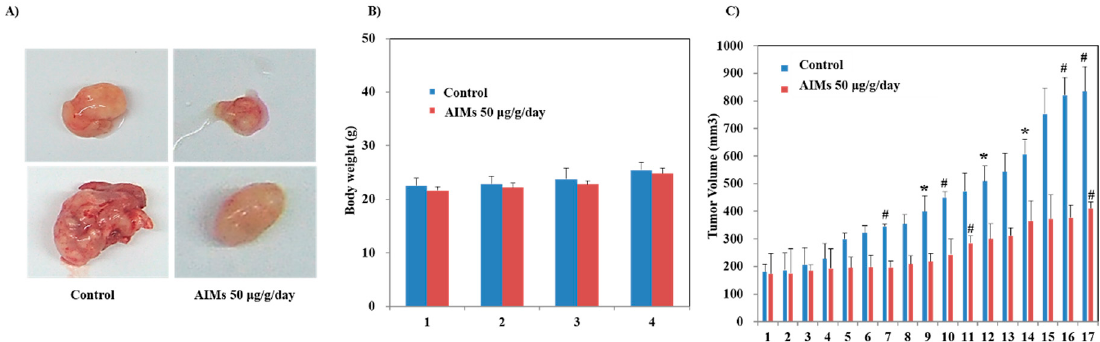
Figure 2. The effect of AIMs on body weight and the tumor. The AIMs were administered to mice at 50 µg/g/day. ( A ) The representative figures are for the largest and smallest tumors. The size of the tumors is highly reduced by the treatment of AIMs. ( B ) The body weight is measured every week until the fourth week. The body weight of mice did not alter with the treatment of AIMs. This shows that the AIMs treatment shows no clinical signs of toxicity and no change in body weight. ( C ) The volume of the tumor was significantly reduced with the treatment of AIMs. The data are shown as the means ± SD of three independent experiments. * p < 0.05 between the treated and the untreated control group. # p < 0.01 between the treated and the untreated control